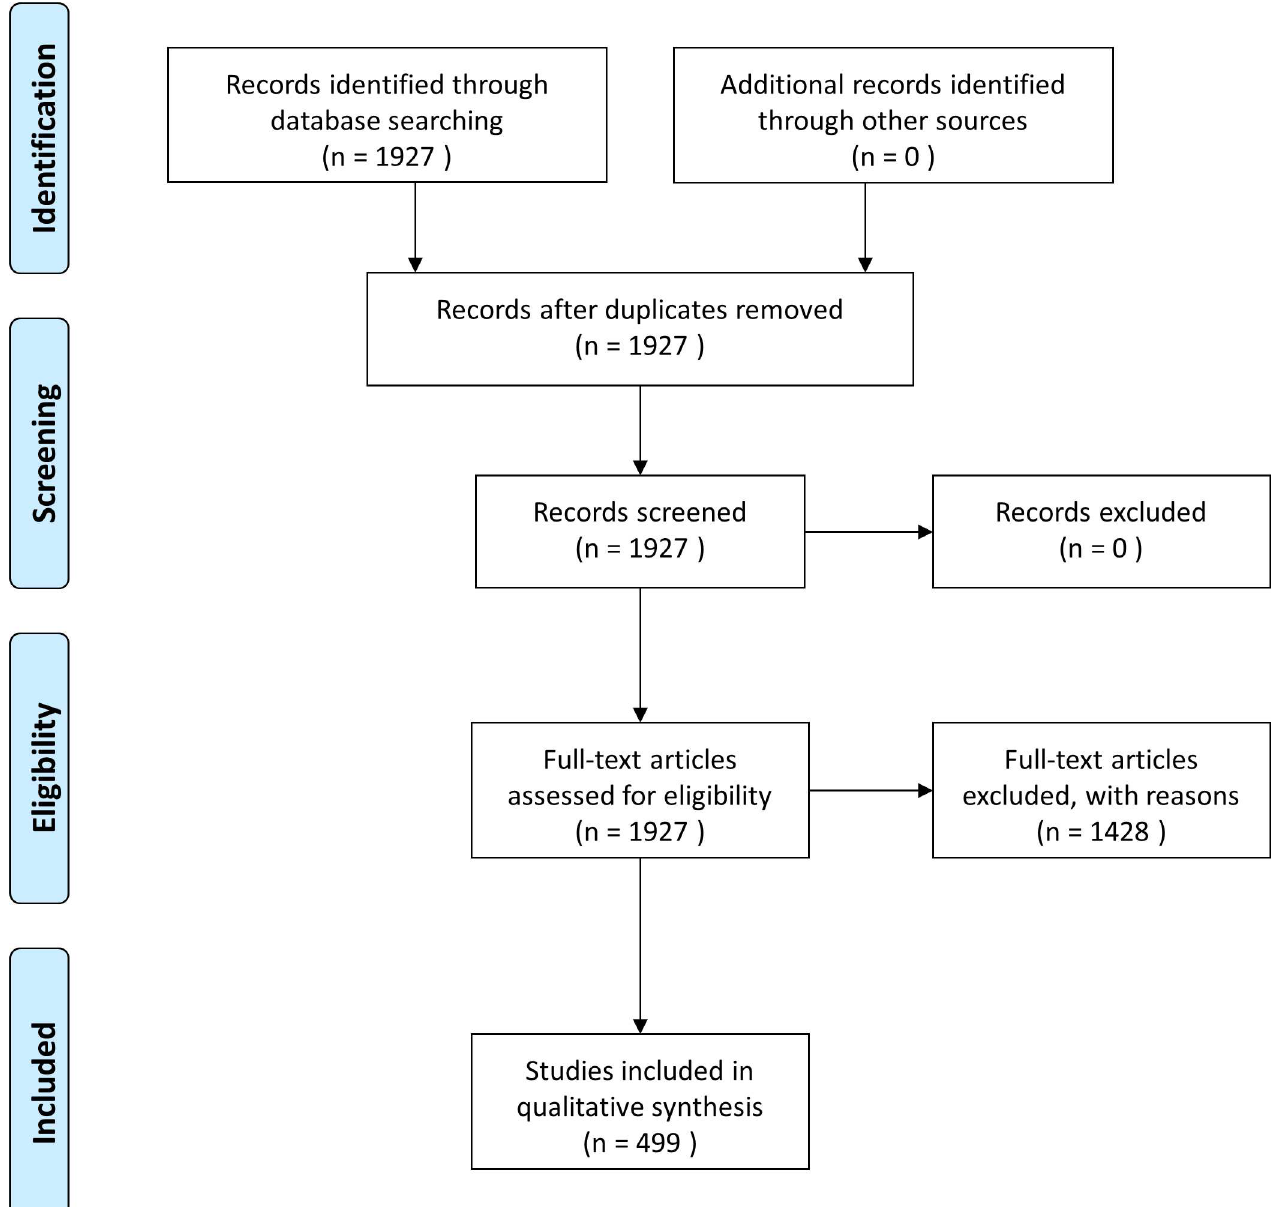
Fig 1. Search strategyand study